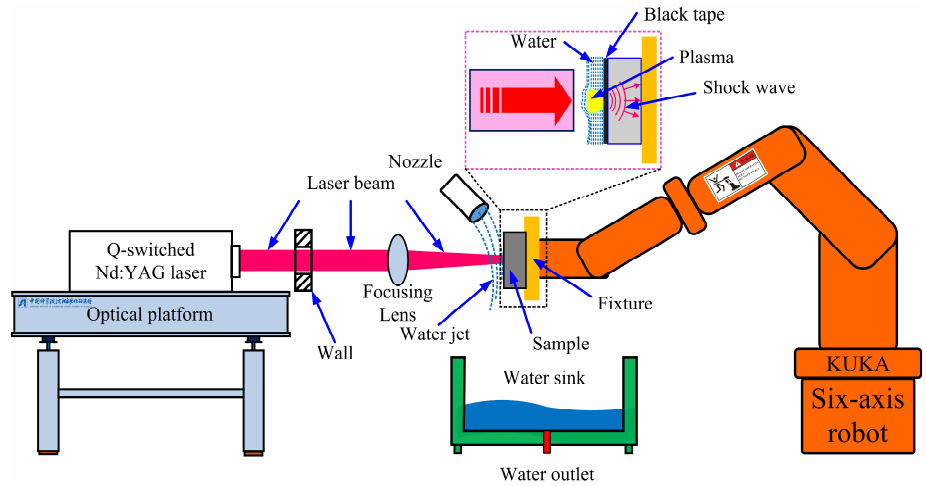
Figure 1. The schematic diagram of LSP treatment employed in this work.